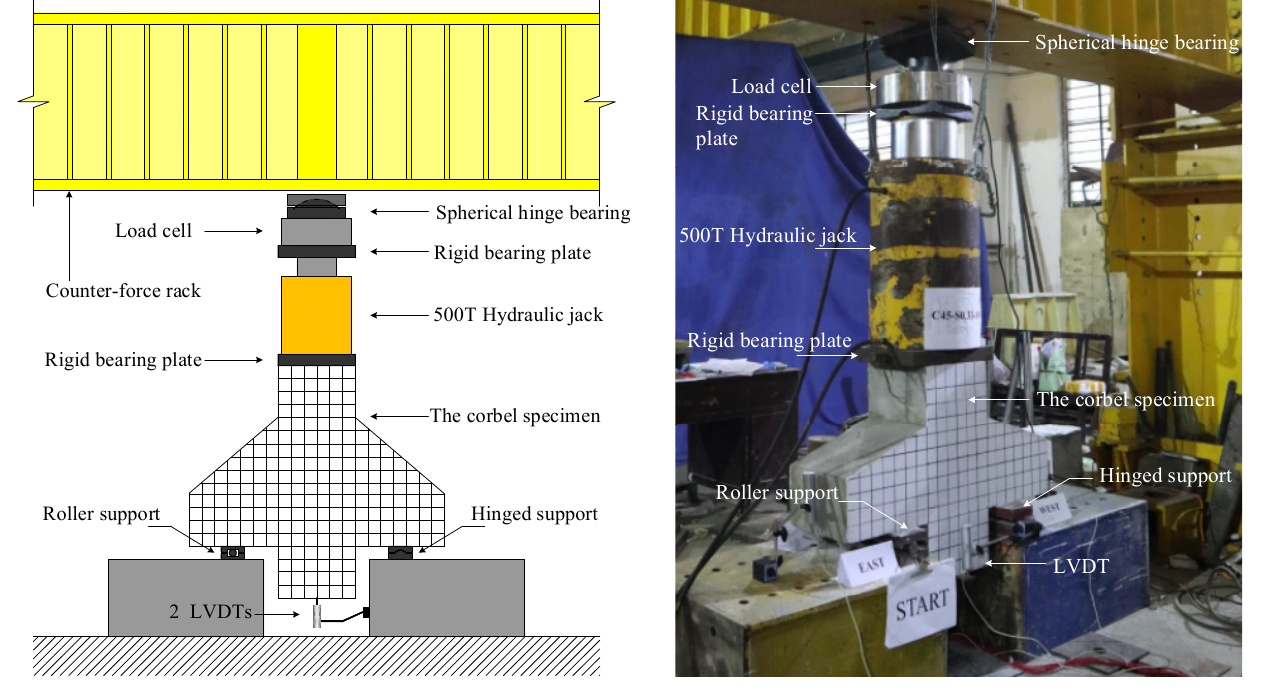
Figure 3. Test setup.